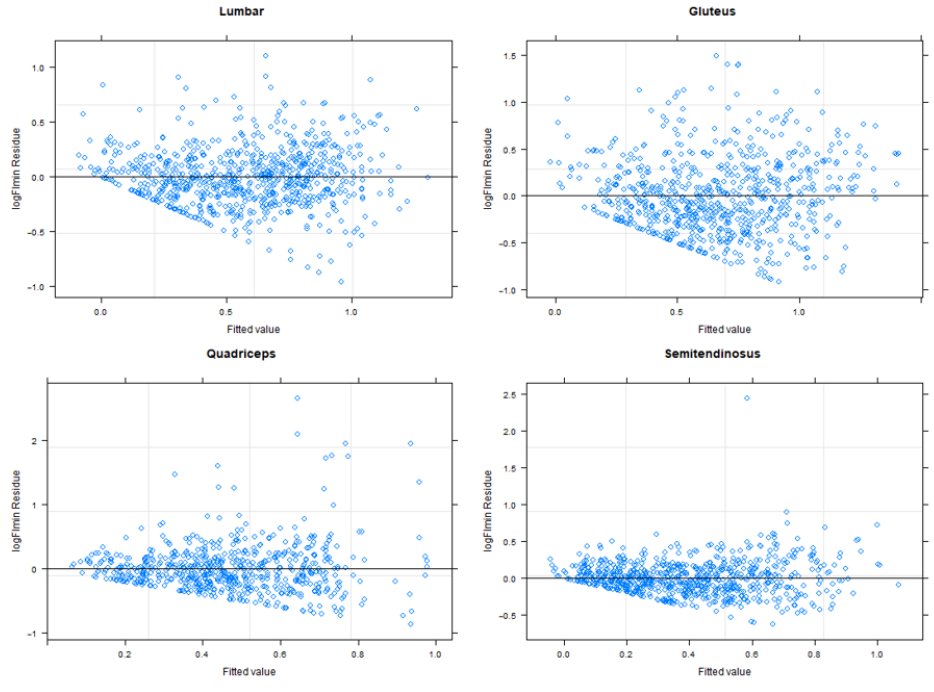
Figure A5. Plot of residues, fitted values minus observed values, over the fitted values for Log(Fimin) for each muscle mixed model.